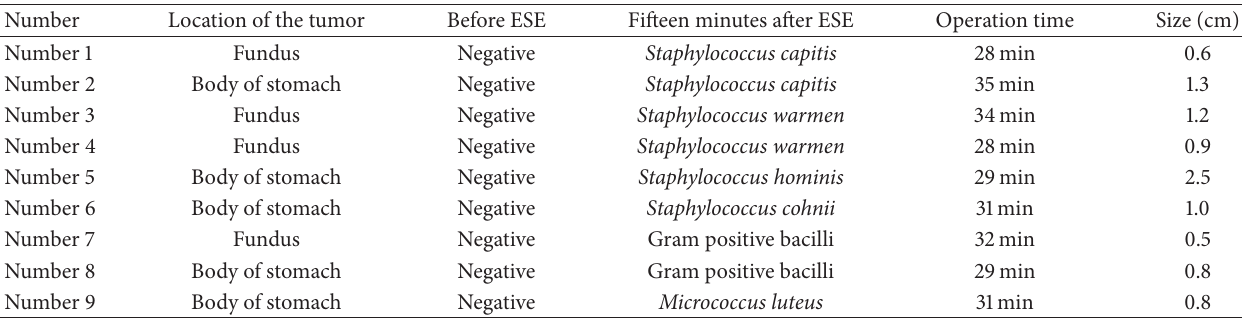
Table 1: The positive blood culture